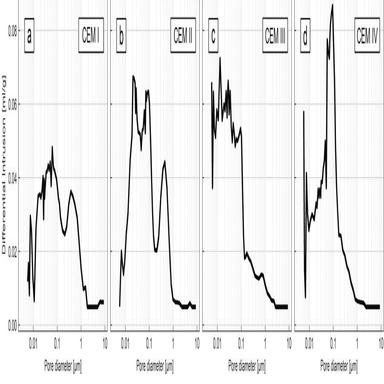
Pore size distribution for (a) CEM I, (b) CEM II, (c) CEM III and (d) CEM IV mortars after 47 weeks of chloride exposure.